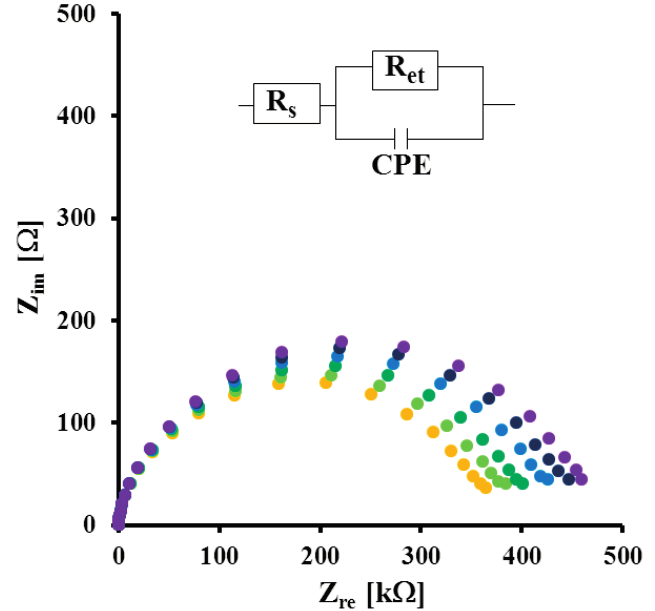
Figure 4. The typical electrochemical impedance spectra of